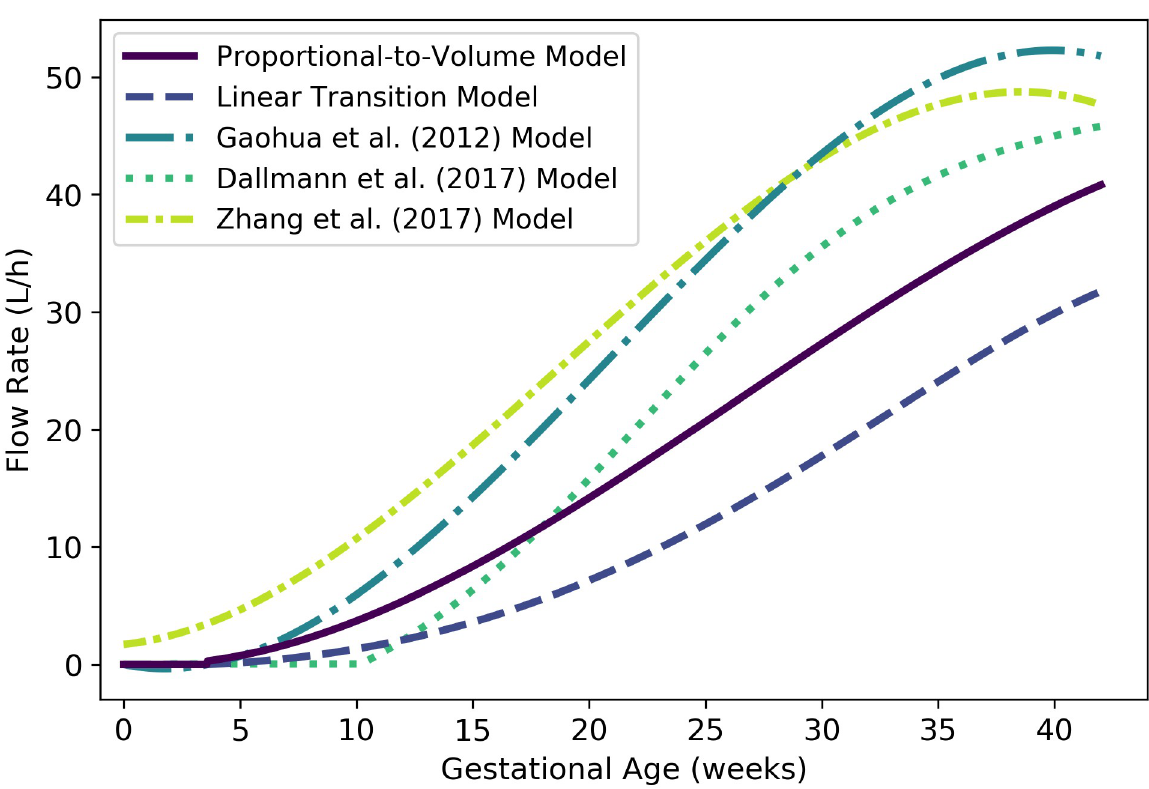
Fig 11. Maternal blood flow to the placenta vs. gestational age. The proportional-to-volume model (solid line) given by Eq 22, the linear transition model given by Eq 21, and two published models [3, 29, 32] are shown.